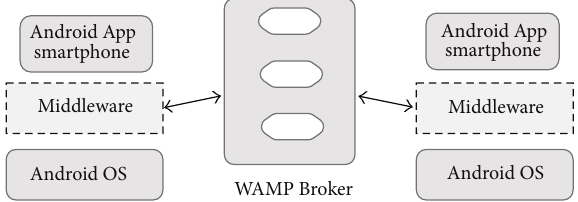
Figure 2: Pub/Sub communication model.